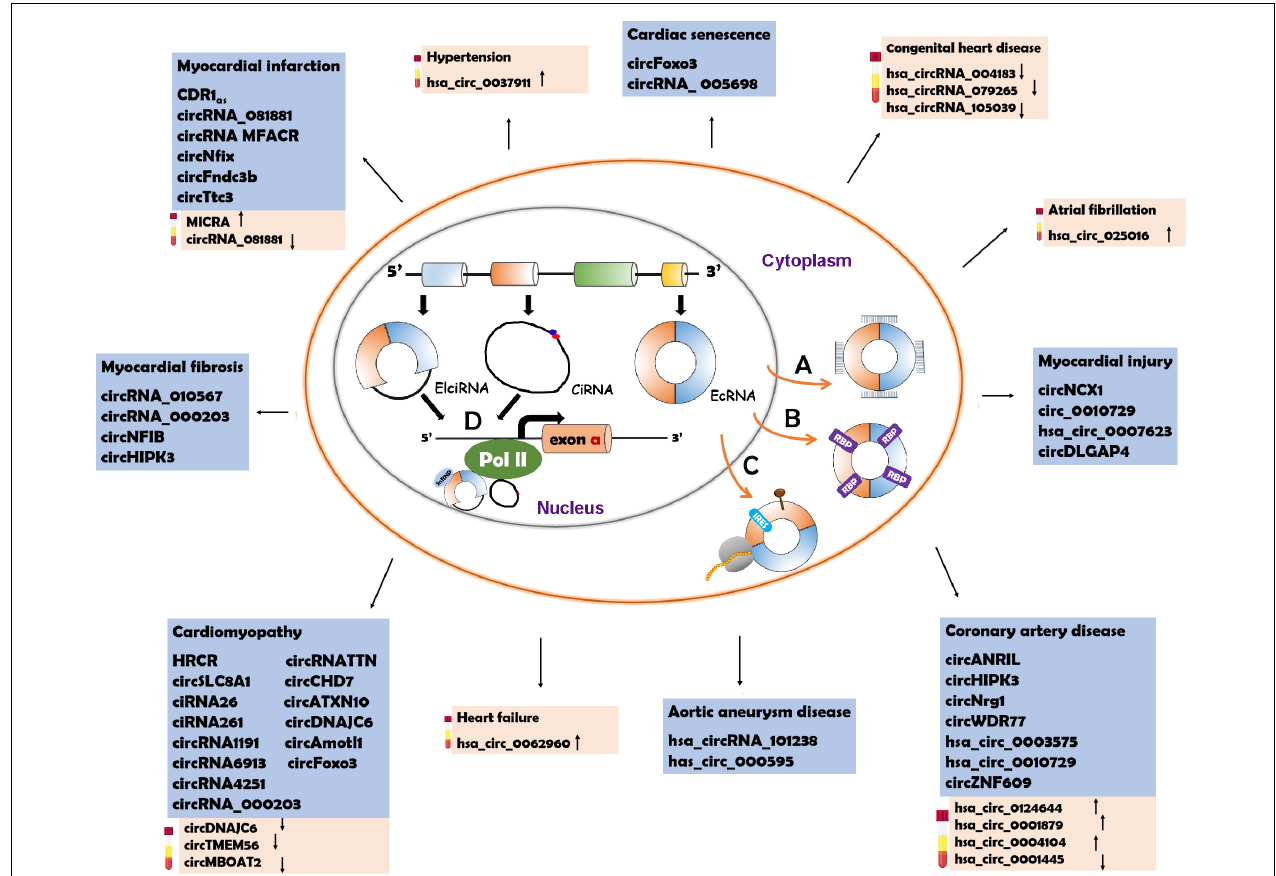
FIGURE 2 | Underlying action mechanisms of circRNAs and the circRNAs relevant to CVD pathogenesis. (A) CircRNAs can serve as miRNA sponges to regulate the functions of miRNAs. (B) CircRNAs can bind to RNA binding proteins (RBPs ) to influence their functions. (C) CircRNAs can be the templates to encode proteins ) elements or m 6 A-modification (brown pin ). (D) circRNAs with intronic sequences can regulate the expression of parental genes through binding to RNA polymerase II (Pol II). The circRNAs involved in CVD are listed in the blue box. The possible diagnostic biomarkers